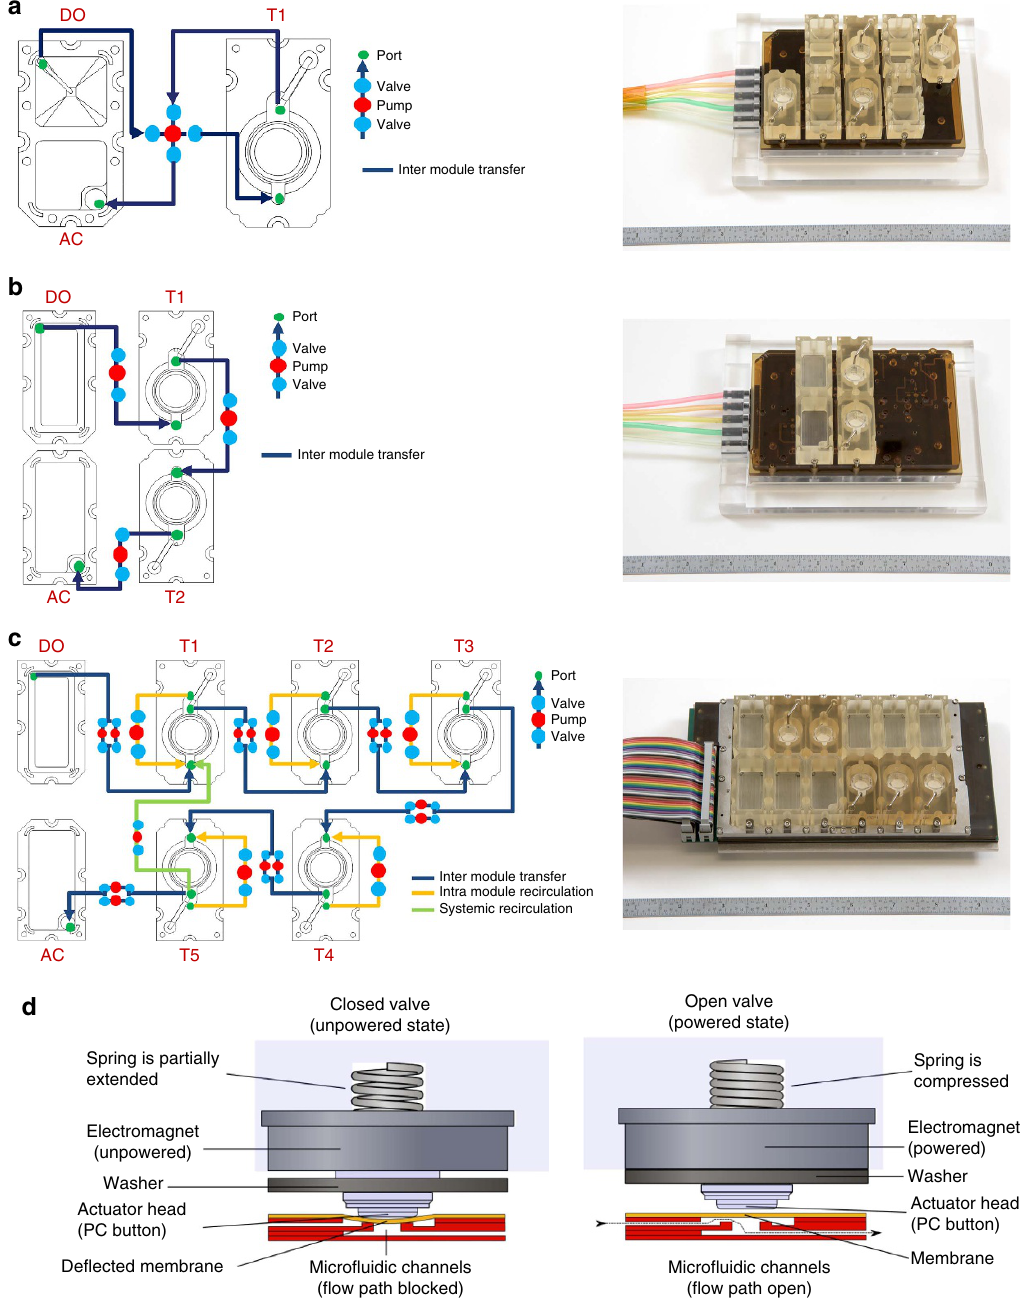
Figure 1 | Microfluidic platform design. Digital images and flow diagrams illustrating the pump pathways of the ( a ) Solo-MFP, ( b ) Duet-MFP and ( c ) Quintet-MFP systems. ( d ) Illustration of the pump mechanism of the electromagnetic Quintet-MFP. AC, acceptor module; DO, donor module; T, tissue